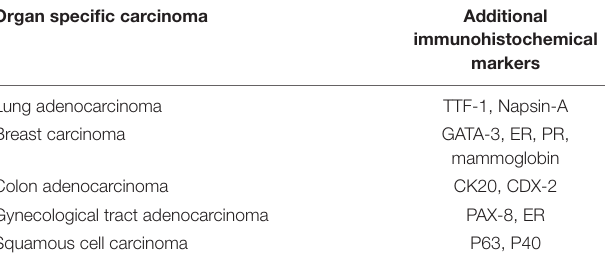
TABLE 3 | Additional immunohistochemical markers to aid in determining origin of metastatic adenocarcinoma or metastatic squamous cell carcinoma (2, 18, 19). Organ specific carcinoma Additional immunohistochemical